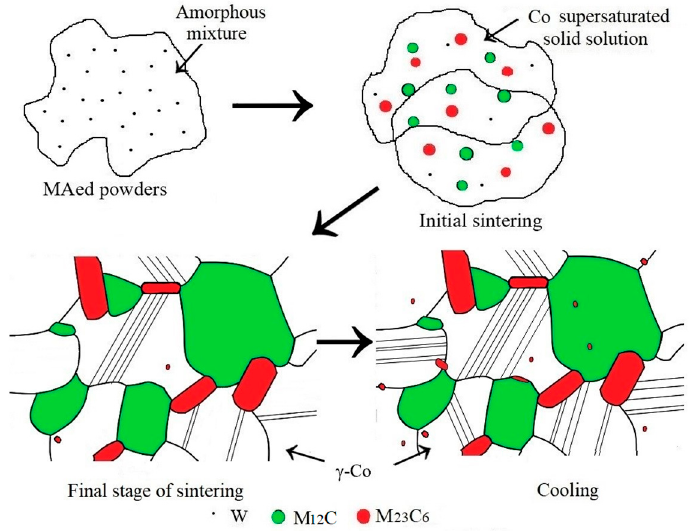
Figure 8. Schematic illustration of the microstructure evolution of cobalt-based alloy during hot pressing sintering and